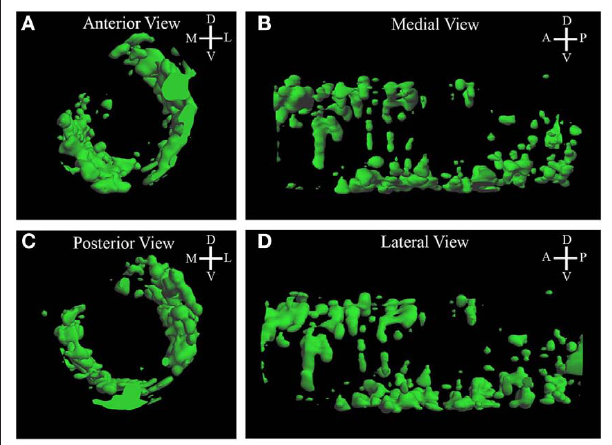
Figure 3 | Three-dimensional reconstruction of Pcdh10 glomerular expression in P0 bulb. (A,D) In the anterior bulb pcdh10 is detected primarily in lateral glomeruli. (B,C) In the posterior olfactory bulb, pcdh10 is detected primarily in ventral glomeruli.